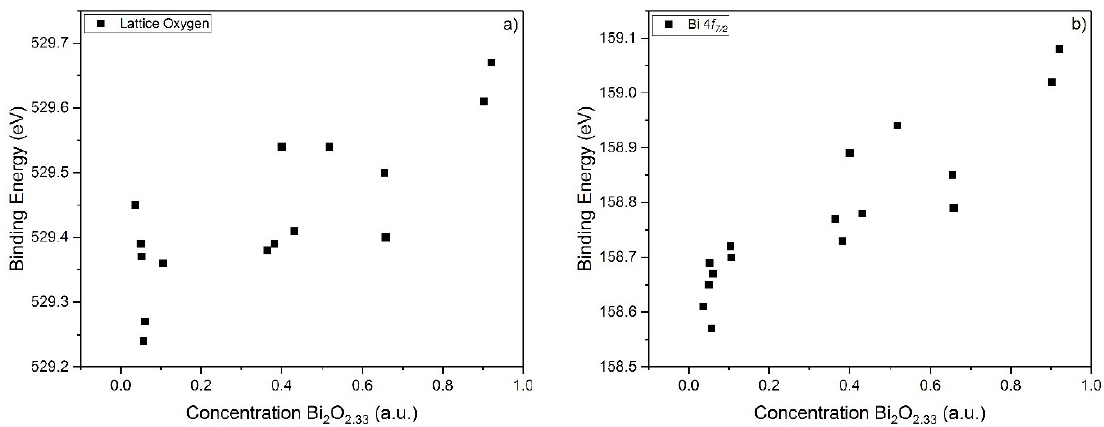
Figure 4. Peak displacement of lattice oxygen ( a ) and bismuth ( b ) depending on the phase fraction.